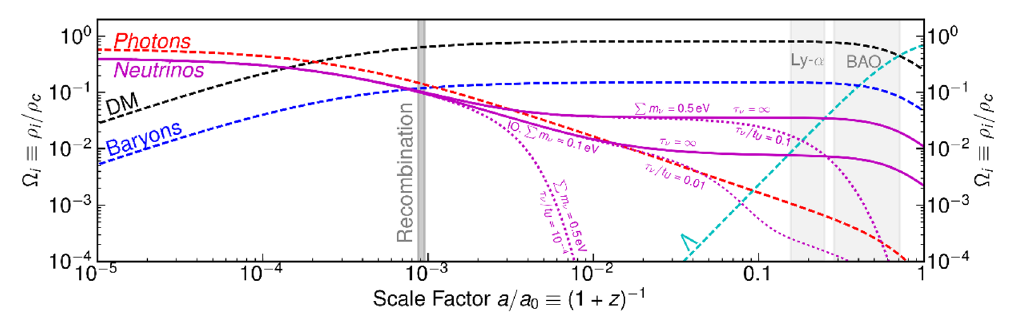
Figure 2 . Energy density evolution for several neutrino decay scenarios. The period in which recombination takes place and the ones relevant for the Lyman- α forest and Baryon Acoustic Os- cillations data are indicated by the grey regions. We show the contribution to the energy density from photons (red), neutrinos (magenta), dark matter (black), baryons (blue), and dark energy (cyan). Note that for the sake of simplicity we do not show the energy density of the neutrino decay